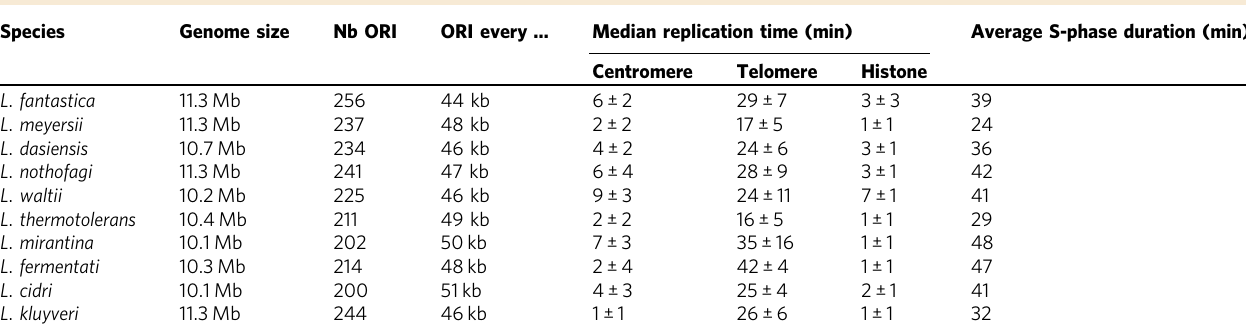
Table 1 Replication pro fi le features